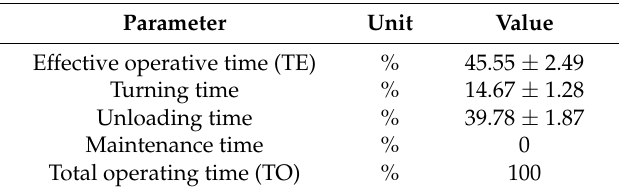
Table 6. Working time of the harvester.